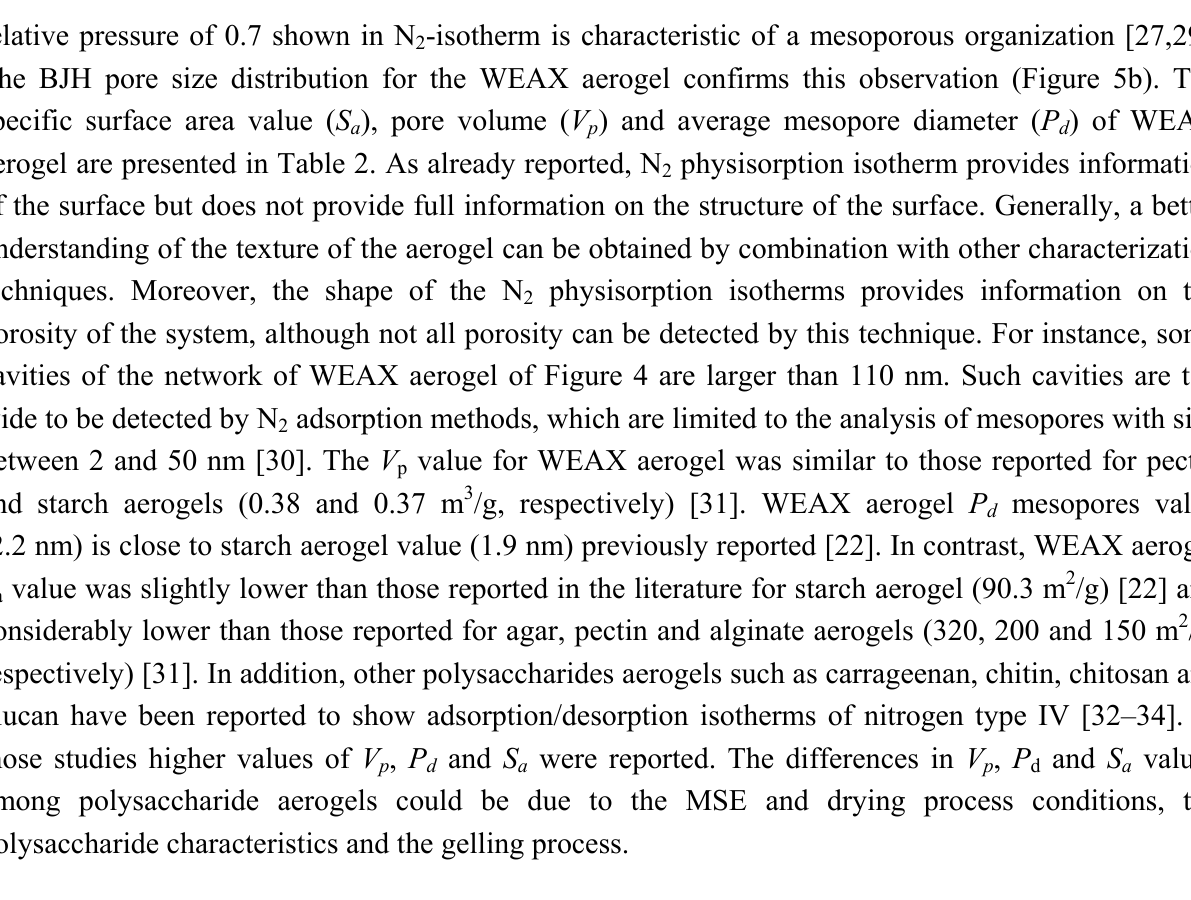
Figure 5. Textural analysis of WEAX aerogel. ( a ) Isotherm. ( b ) Pore size distribution.